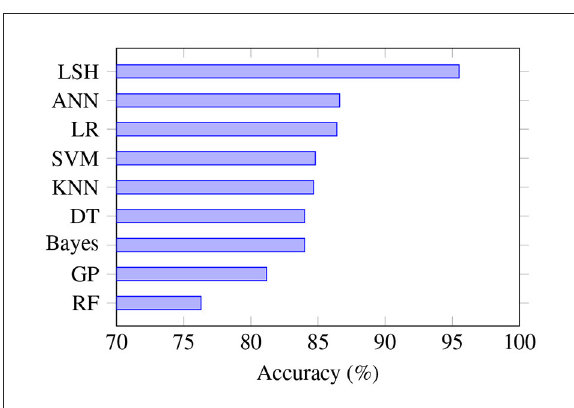
FIGURE3 Prediction accuracy based on the type of algorithm. LSH is the most accurate algorithm, although only a few studies used it. SVM is the algorithm that was most often studied, and RF is the least accurate algorithm. RF, random forest; GP,